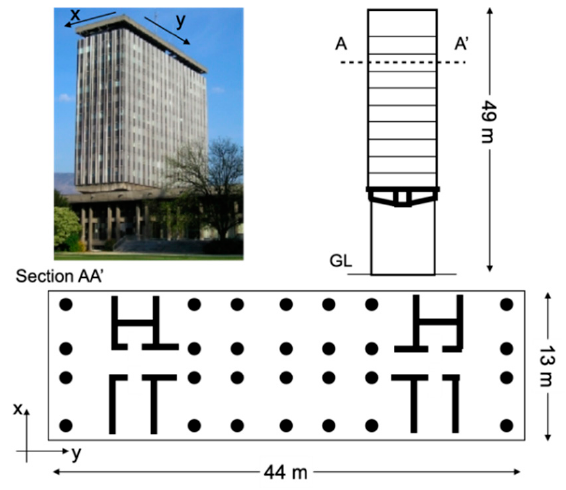
Figure 1. Representation of the structure of Grenoble city hall (GCH).